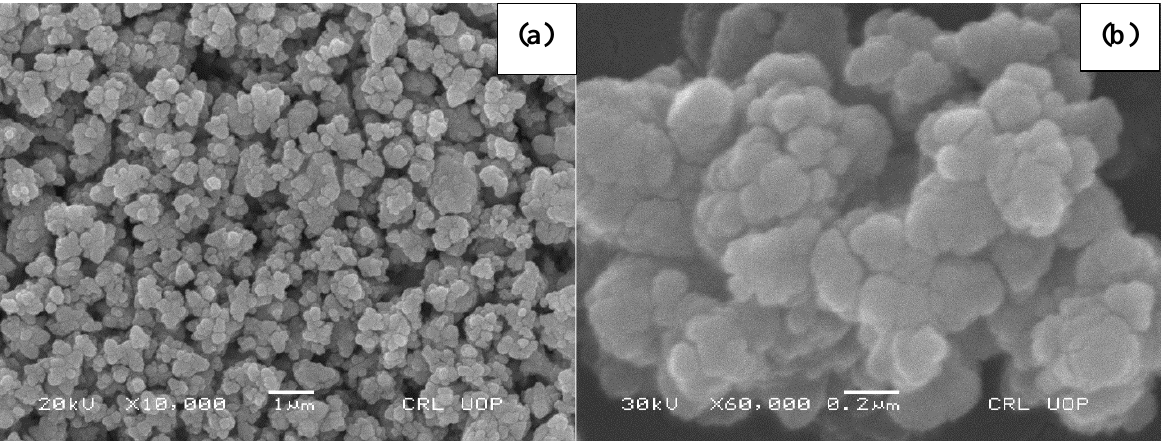
Figure 3. SEM micrographs of SnO 2 NPs. ( a ) × 10,000; ( b ) × 60,000.